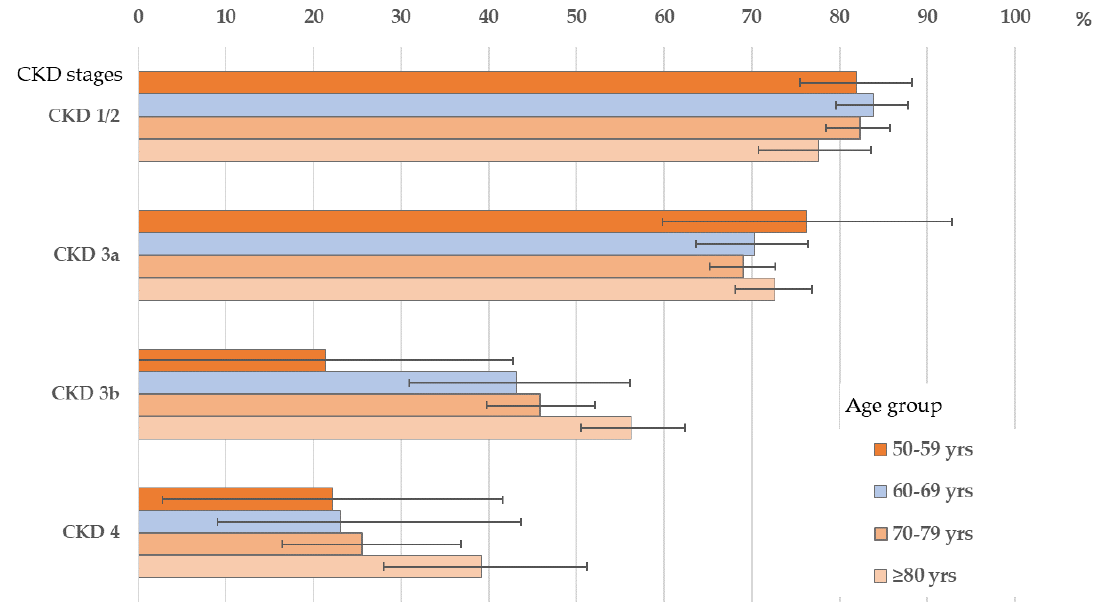
Figure 3. Prevalence (and 95%-CI) of unawareness in CKD Stages 1 or 2, 3a, 3b and 4 according to age group. Unawareness of CKD remained high in later CKD stages (about 50% in CKD Stage 3b such as hypertension, diabetes or overweight (Figure 4 and Supplementary Table S1).